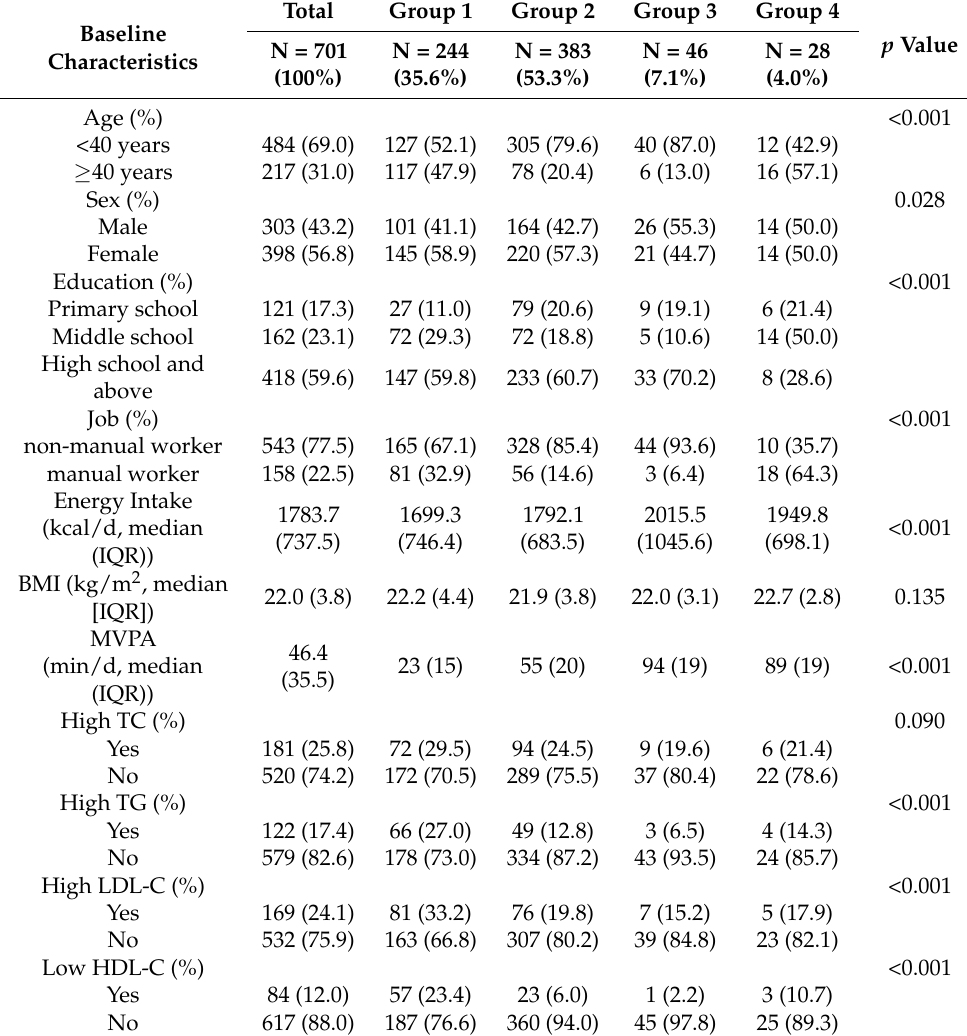
Table 2. Characteristics of participants in the four physical activity trajectory